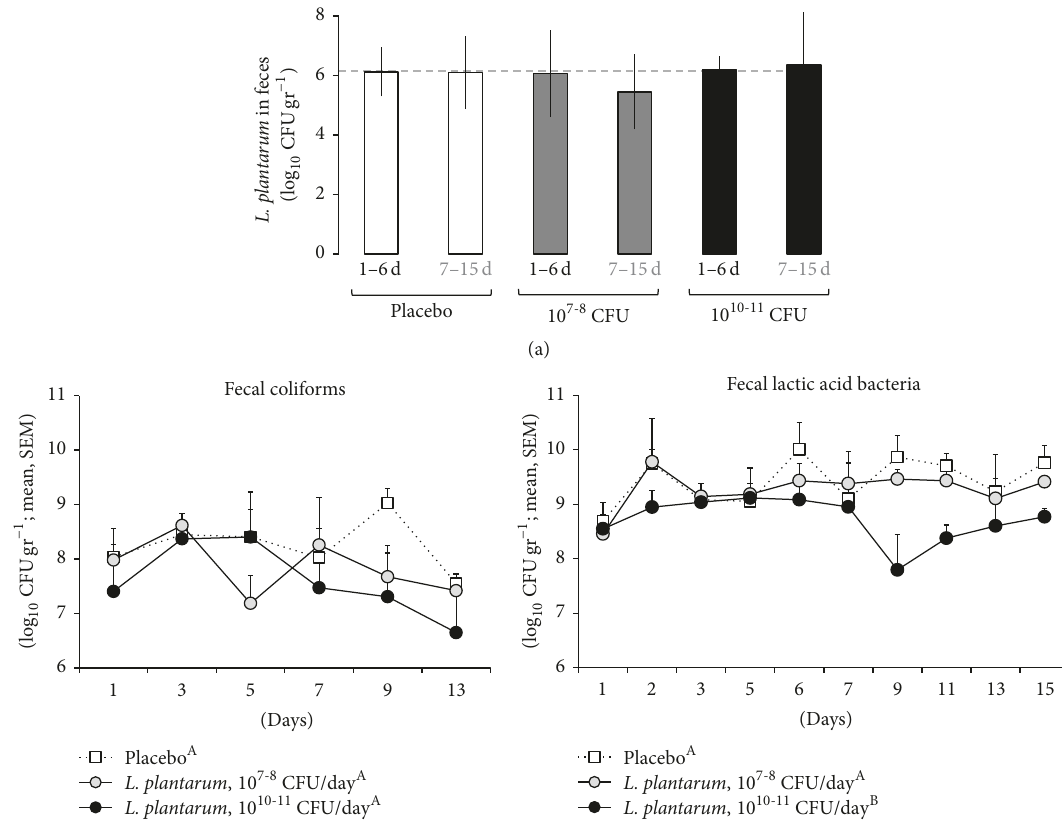
Figure 3: Quantitative effect of L. plantarum ( Lplant -B80) administration on other fecal cultivable microbiota. (a) Selective enumeration of L. plantarum B80 based on phenotype and BBL biochemical profile. Data for the first 6 days of treatment and the follow-up period (7–15 days). Average ± SD. (b) Total fecal coliforms and lactic acid bacteria. High doses tended to lower fecal coliforms, but it significantly